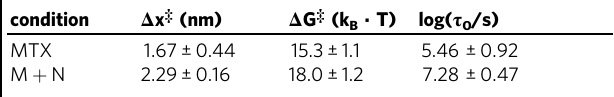
The table shows the mean ± standard deviation for the distance to the transition state, barrier height, and intrinsic folded state lifetime ( Δ x ‡ , Δ G ‡ , τ 0